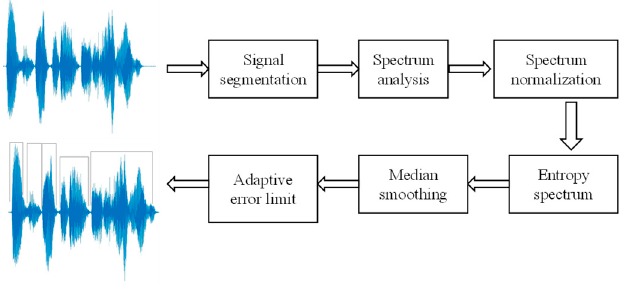
Figure 1. Method of speech separation based on spectral entropy analysis.